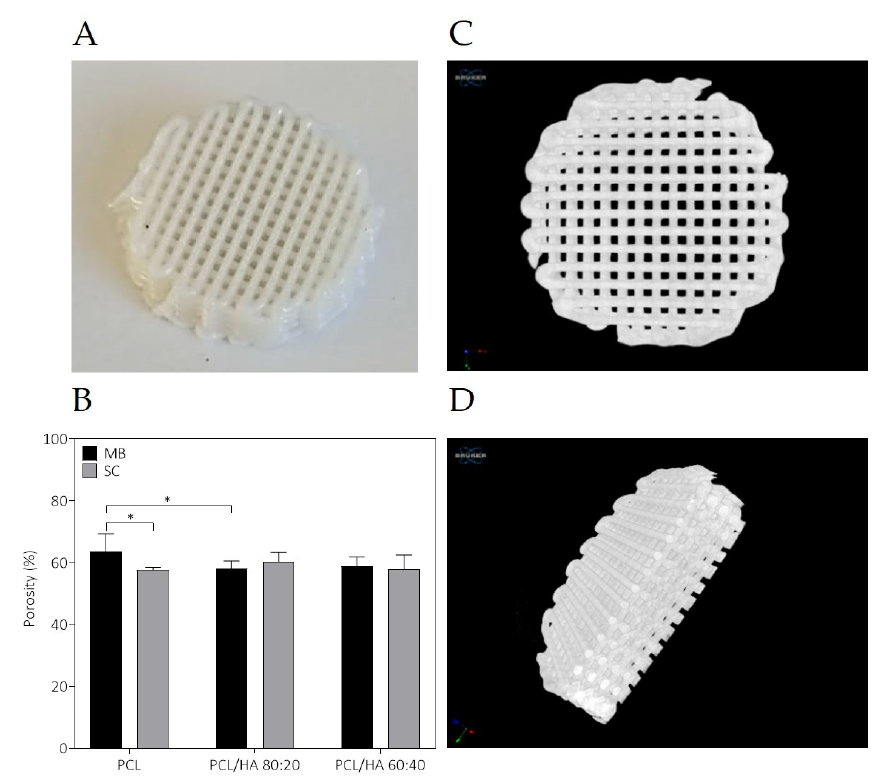
Figure 4. Final appearance of a PCL/HA scaffold ( A ) and porosity obtained of the MB and SC scaffolds ( B ). Micro-CT image of a scaffold allowing the identification of interconnectivity between pores: top-view ( C ) and cross section view ( D ). The results presented in mean ± SE. Differences were considered statistically significant at p ≤ 0.05. Results’ significance is presented through the symbol (*), according to the p value, with one symbol corresponding to 0.01 < p ≤ 0.05. SEM micrographs of PCL, PCL/HA 80:20 and PCL/HA 60:40 scaffolds of the